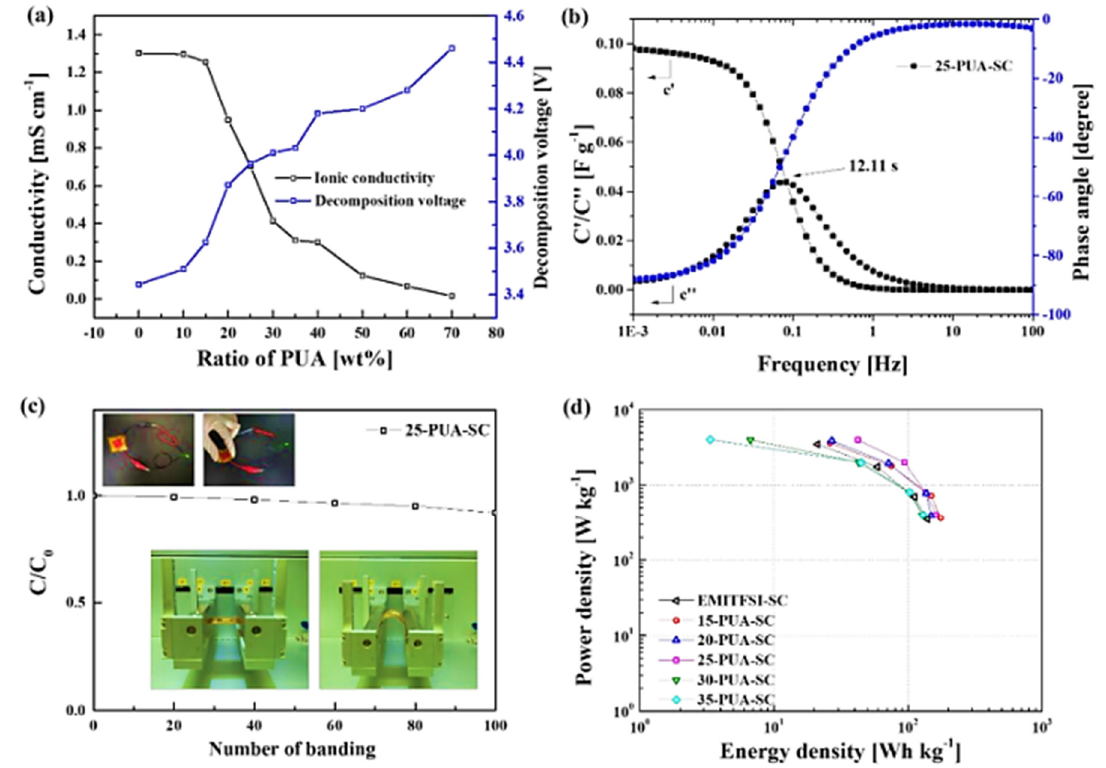
Figure 16. ( a ) Ionic conductivities and decomposition voltages of [EMI][TFSI] and ion gel; ( b ) relaxation time and phase − angle of SC based on ion gel; ( c ) bending test of SC based on ion gel and photographs of a light-emitting diode working at 4 V; ( d ) Ragone plots of SC based on ion gel. Reprinted 2021 from [98] with permission from Elsevier.